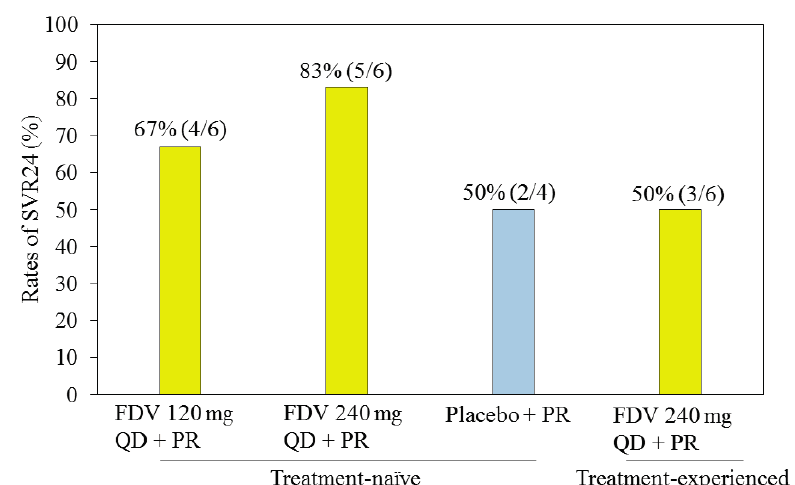
Figure 3. Results of a phase 2 study of faldaprevir (FDV) plus pegylated interferon (P) and ribavirin (R) in Japanese patients with chronic HCV genotype 1 infection [27]. Treatment-naive patients received FDV 120 or 240 mg QD, or placebo, plus PR